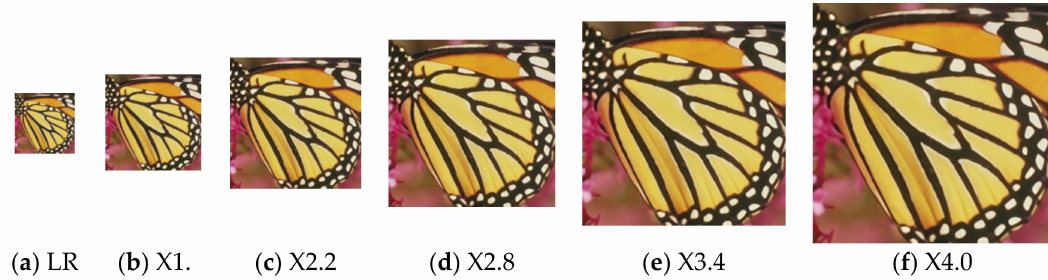
Figure 2. SR images generated by the proposed method at multiple